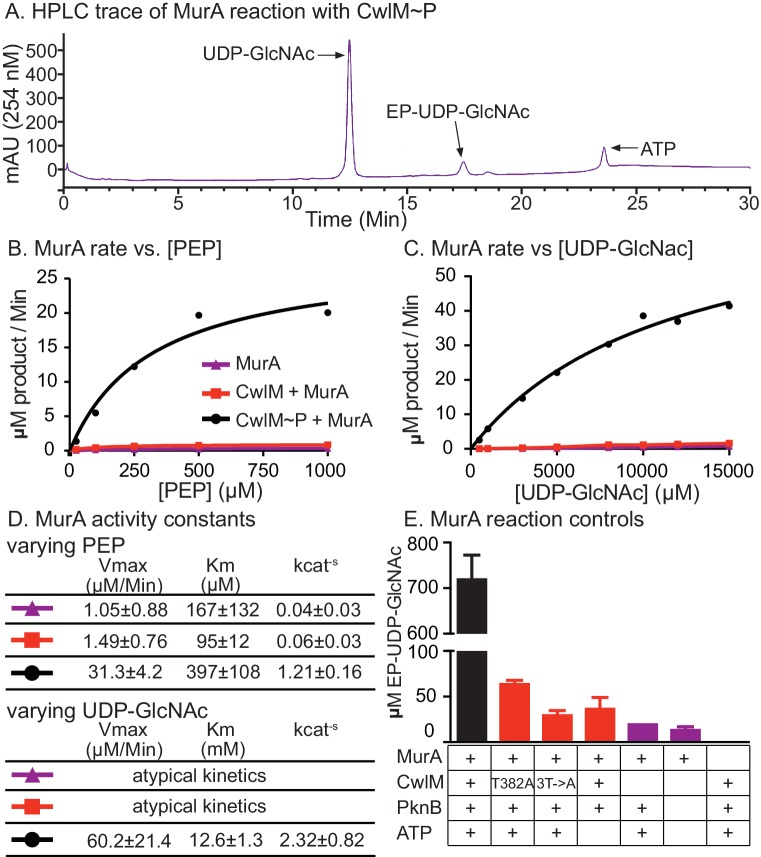
CwlM~P activates MurA in vitro.(A) An HPLC trace from the MurATB kinetic assays, with substrate UDP-GlcNAc and product EP-UDP-GlcNAc indicated. Assays were done on his-MurATB alone, his-MurATB with equimolar his-CwlMTB~P in an active kinase reaction (+ATP) with his-MBP-PknBTB(KD) (a his-Maltose binding protein fusion to the kinase domain (KD) of PknB from Mtb), or his-MurATB with his-CwlMTB in an inactive kinase reaction (-ATP) with his-MBP-PknBTB(KD). (B) Rate of MurA activity vs. the concentration of phosphoenol pyruvate (PEP). Lines are the fit to the Michaelis Menten model. (C) Rate of MurA activity vs. the concentration of UDP-GlcNac for each MurA reaction condition. MurA and MurA+CwlM did not follow Michaelis Menten kinetics, (lines only connect the dots), for MurA+CwlM~P the line is the Michaelis Menten fit. The assays shown in (B) and (C) were done twice with two separate preps of his-MurATB and his-CwlMTB. Data from one replicate is shown here, full data in Figure 5 - figure supplement 1A–D. (D) Michaelis Menten kinetic constants from experiments in (B) and (C). Constants are the average ± the 95% confidence interval from the two replicates. (E) Amount of EP-UDP-GlcNAc produced after 30 min at 37°C in reactions with 2 mM PEP and 15 mM UDP-GlcNAc and his-MurATB at 20 µg/ml; his-CwlMTB at 20.2 µg/ml; his-MBP-PknBTB(KD) at 2 µg/ml and ATP at 1 mM where indicated. his-CwlMTB was incubated with his-MBP-PknBTB and ATP for 1 hr at RT before initiating the MurA reaction. T382A indicates that the singly-phosphoablative mutant protein his-CwlMTB T382A was used. 3T->A indicates that the triply-phosphoablative mutant protein his-CwlMTB T382A T384A T386A was used. Experiment was performed 2 times.